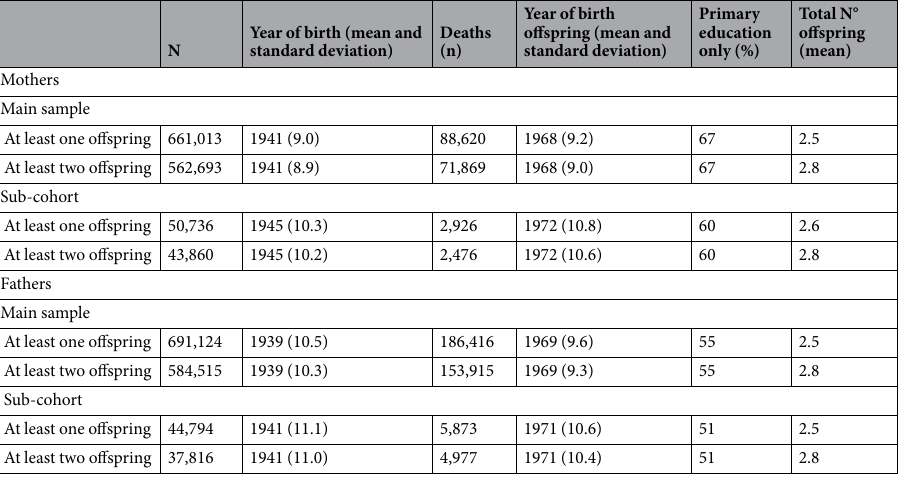
Table 1. Some characteristics according to number of boys and girls in the study